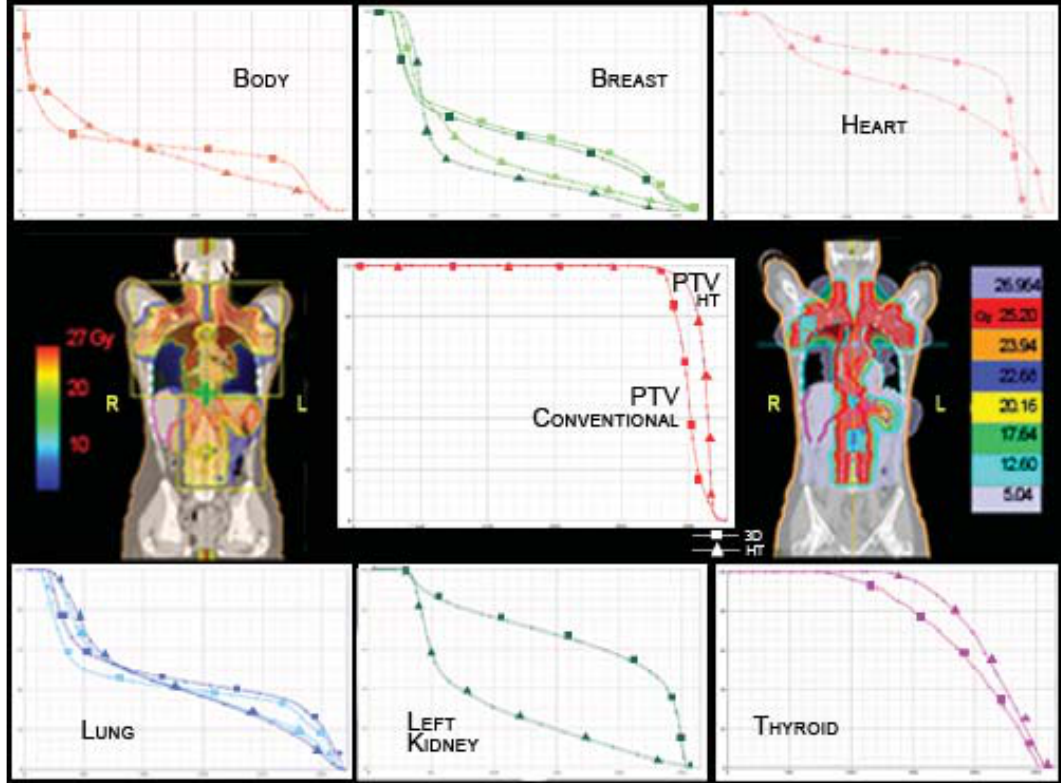
Figure 7. 20-year-old female, Stage IIIA HL, treated with 25.2Gy/14 fractions at the end of chemotherapy. HT has dosimetric advantages compared to the conventional technique in several OARs, whereas whole body HT results in a disadvantage at lower doses and an advantage at higher doses. The total body ID is 9% lower for HT. The HT-DVHs for OARs are marked with triangles for HT and with squares for conventional